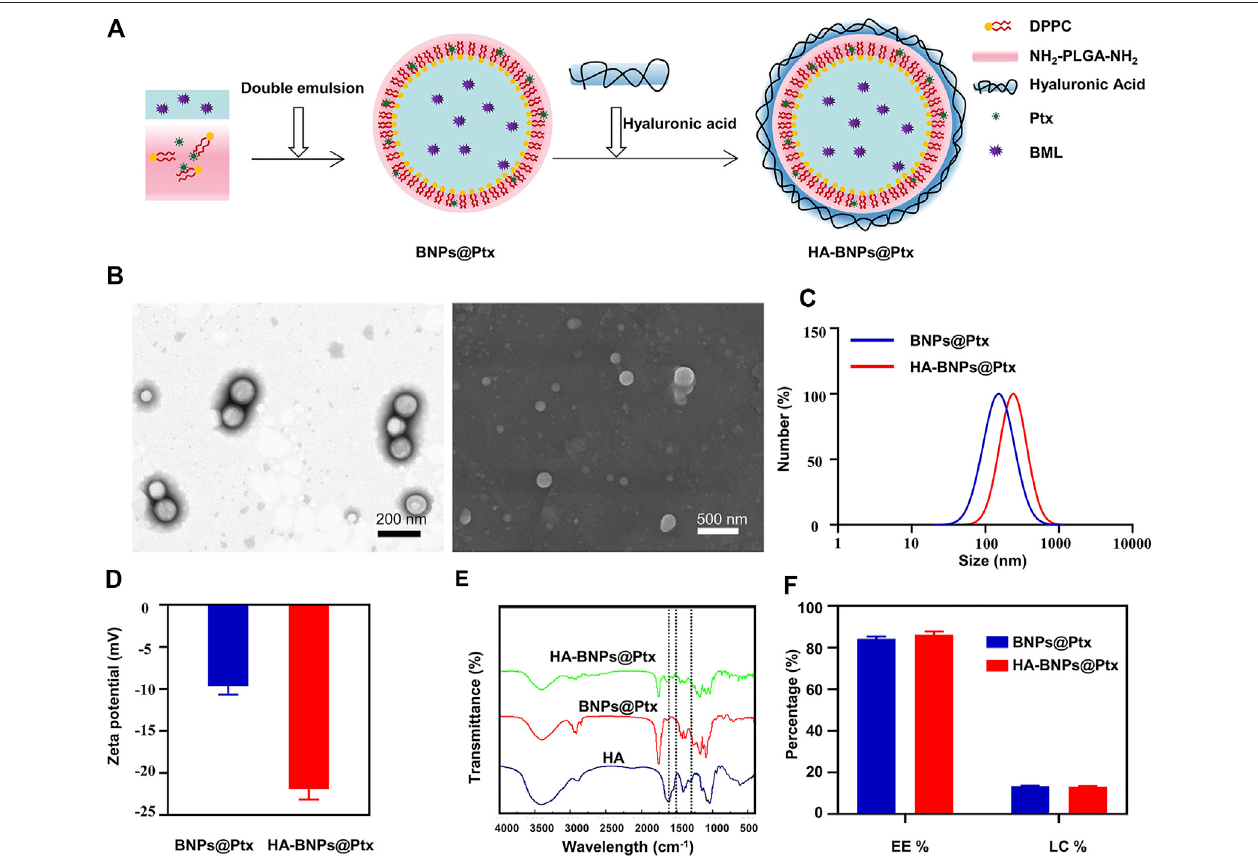
FIGURE 2 | Synthesis and characterization of nanoparticles used in synergistic cascade strategy study. (A) BNPs@Ptx preparation and hyaluronic acid (HA) conjugation. (B) Transmissionelectronmicroscopy(TEM)andscanningelectronmicroscope(SEM)imageofHA-BNPs@Ptx. (C) Sizedistributionand (D) zetapotentials of BNPs@Ptx and HA-BNPs@Ptxdetermined by dynamic light scattering (DLS) ( n (cid:2) 3). (E) Fourier transform infrared spectrometer (FTIR) spectrumsofHA, BNPs@Ptx, and HA-BNPs@Ptx (amide bond: 1,656, 1,546, and 1,334 cm − 1 ). (F) Encapsulation ef fi ciency (EE) and loading capacity (LC) of Ptx in HA-BNPs@Ptx and BNPs@ Ptx determined by spectrophotometer ( n (cid:2)